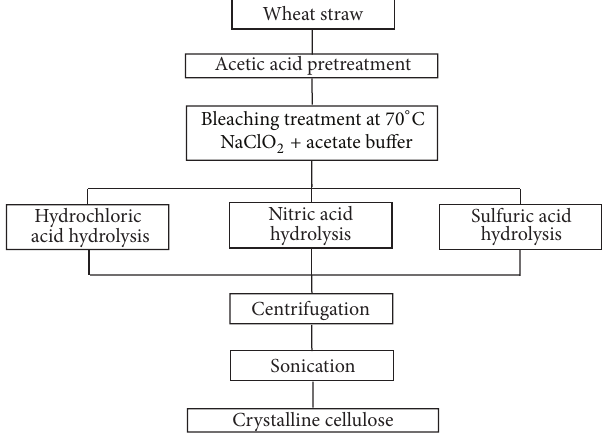
Figure 1: Showing the synthesis methodology for the extraction of crystalline cellulose from wheat